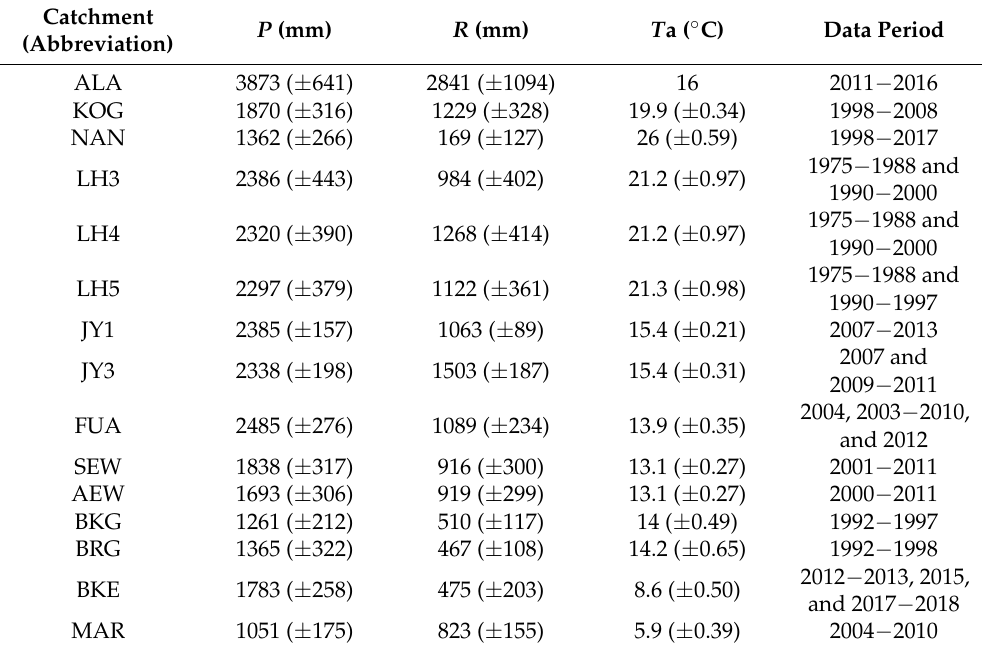
Table 3. Mean annual rainfall ( P ), runoff ( R ), and air temperature ( T a) in each catchment throughout the studied period. N.A. = not